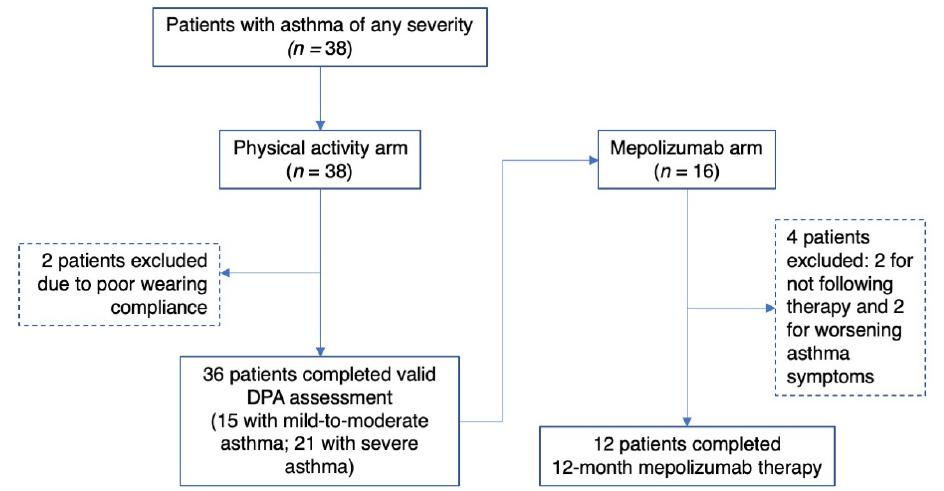
Figure 1. Study flowchart. DPA: Daily physical activity.